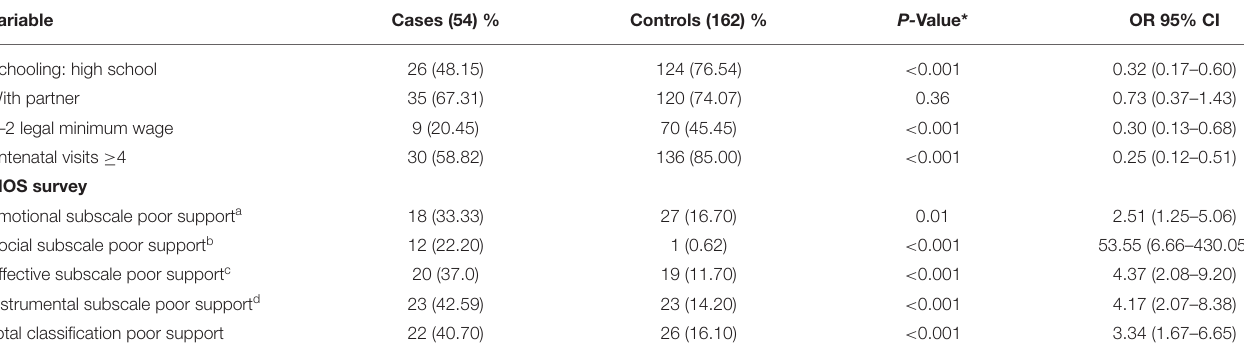
TABLE 4 | Bivariate analysis between perinatal asphyxia and social